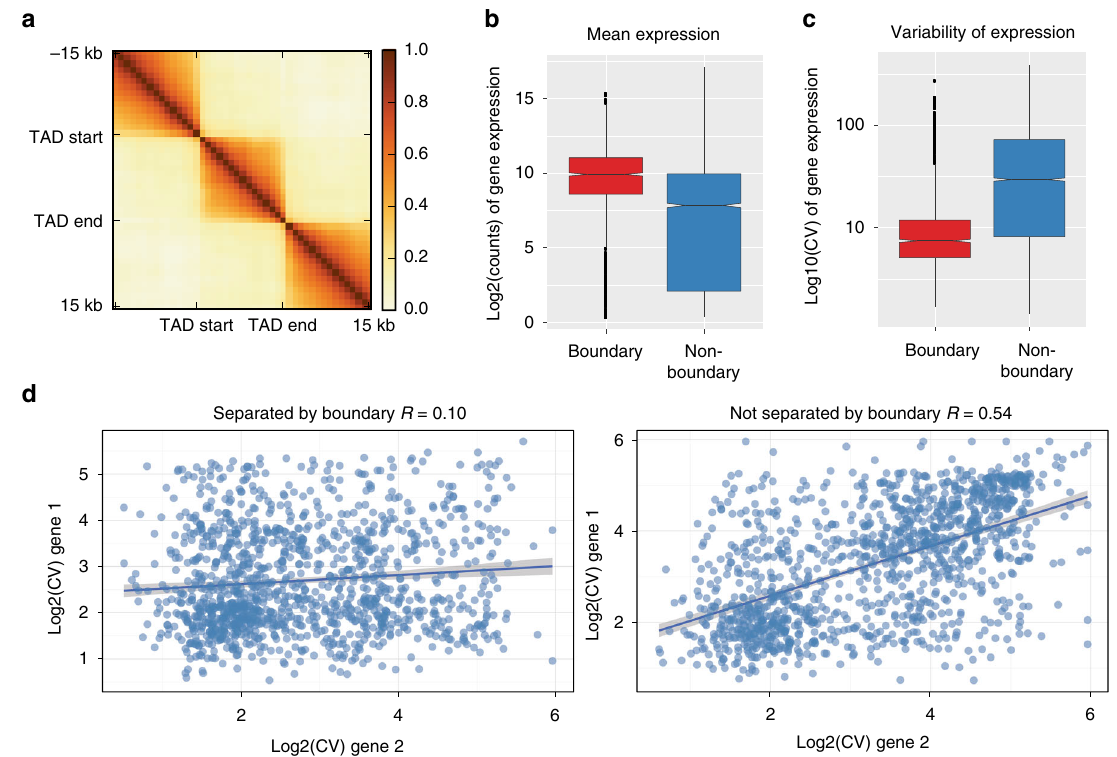
Fig. 2 TAD boundaries are marked by speci fi c gene orientation and transcription. a Correlation of mean expression across developmental stages inside TADs vs. outside. Region inside TADs was scaled to 15 kb. Each pixel in the matrix contains the pearson correlation at different distances. b – c Mean expression (in Kc167 cells) and variability of expression (during development) for genes whose promoters are at a TAD boundary vs. genes whose promoters are not at boundaries. d Coef fi cient of variation (across developmental stages) between pairs of adjacent genes either separated by a TAD boundary (left) or not separated by a boundary (right). Line shows the linear model fi t (shaded region: std.